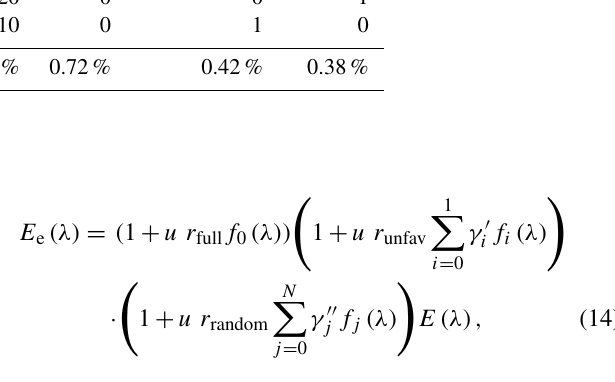
Figure 5. (a) Standard uncertainties in TOC at local noon as a function of the order of complexity N for QASUME spectroradiometer with 1% deviation in spectral irradiance E(λ) plotted as circles and 1% deviation in ozone absorption cross section α O crosses. The distributions of TOC values arising from 1% deviation in E(λ) with the order of complexity of N = 2 in (b) and N = 80 in (c) . The black solid curve denotes a Gaussian distribution. Table 1. Uncertainties in the measurement for the QASUME spectroradiometer. QASUME Standard Correlation fraction Source of uncertainty uncertainty Full Unfavourable Random in measured E(λ) % Radiometric calibration 0.55 1 / 250W lamp stability 0.14 1 0 0 Non-linearity 0.25 0 0 Stability 0.60 Temperature dependence 0.20 Measurement noise 0.20 Wavelength shift 0.10 Combined uncertainty ( k = 1)